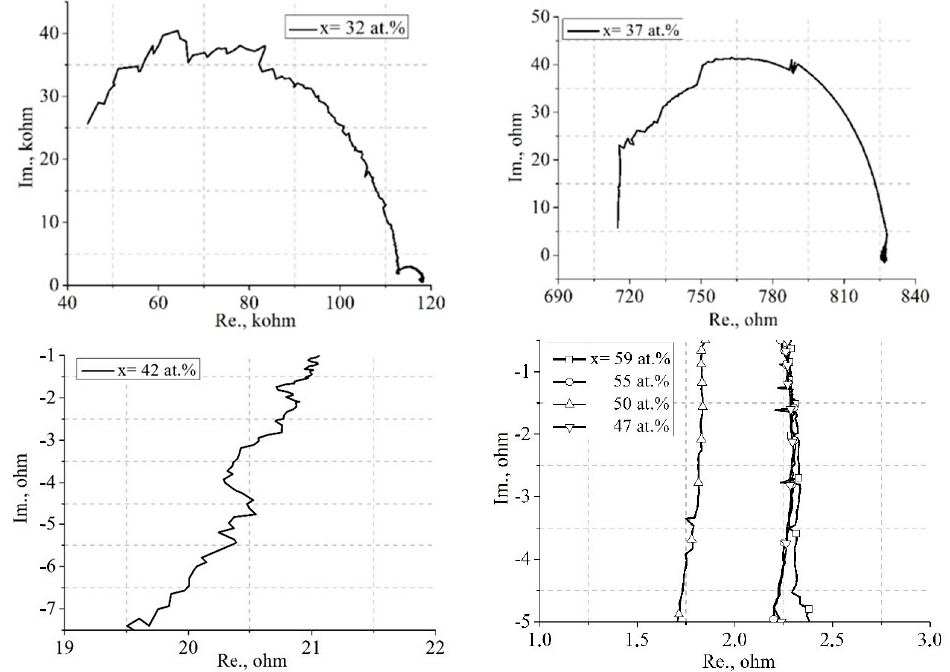
Figure 3. Impedance diagrams (hodographs) for nanocomposites Co x (MgF 2 ) 100-x of different compo- sitions (32 ≤ x ≤ 59).